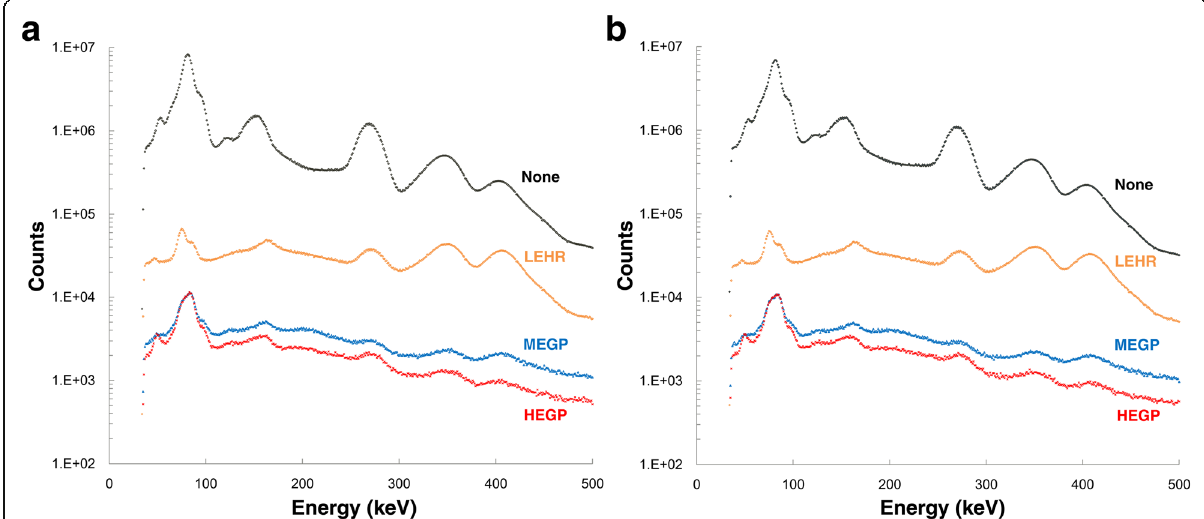
Fig. 1 Energy spectra of a Ra-223 vial around the air ( a ) and a Ra-223 vial in the chamber filled with iodine contrast media (CT value, 350 HU) ( b ) with the LEHR, MEGP and HEGP collimators or without any of collimator. LEHR low-energy high-resolution, MEGP medium-energy general purpose, HEGP high-energy general